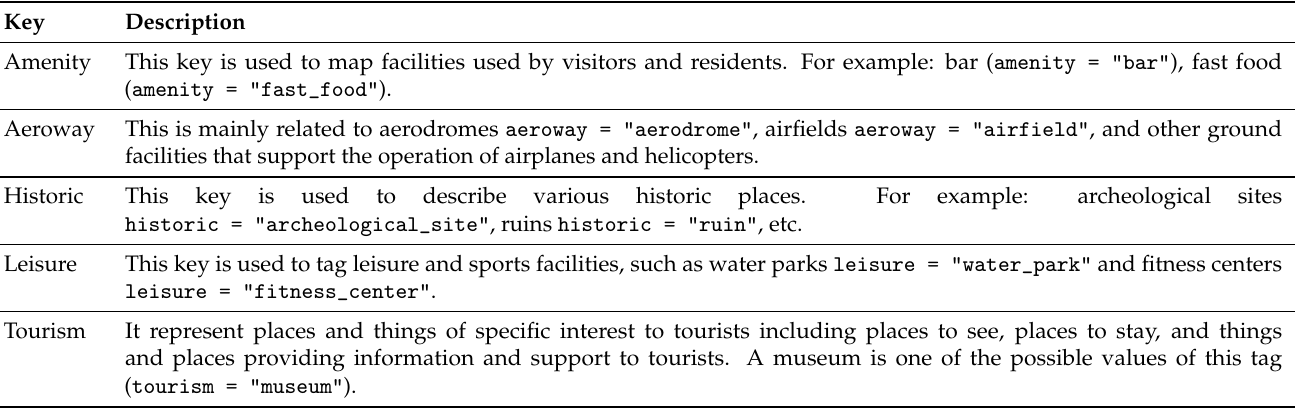
Table 2. Keys of OSM to represent tourism